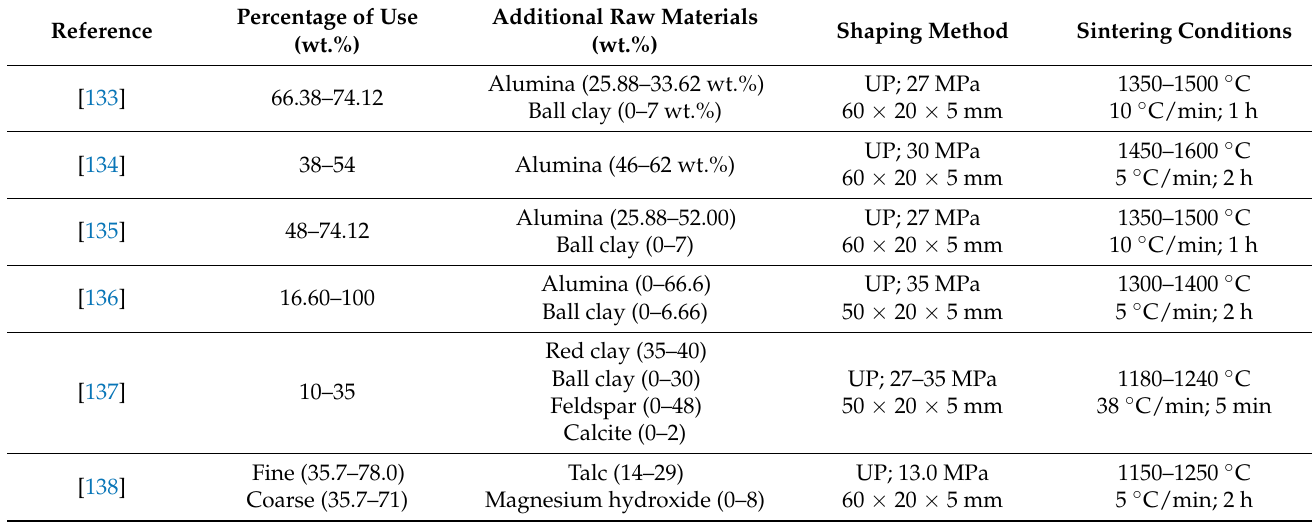
Table 16. Experimental conditions used in the development of mullite-based materials from primary kaolin industry waste.